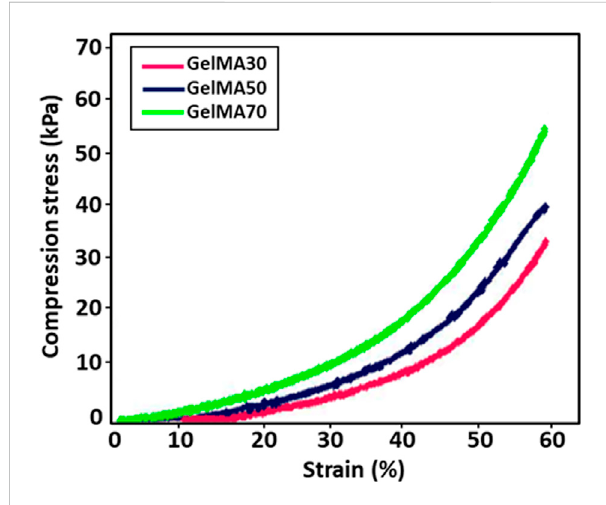
FIGURE 6 Stress-strain curves for GelMA hydrogels at different UV exposure times (30, 50, and 70 s).